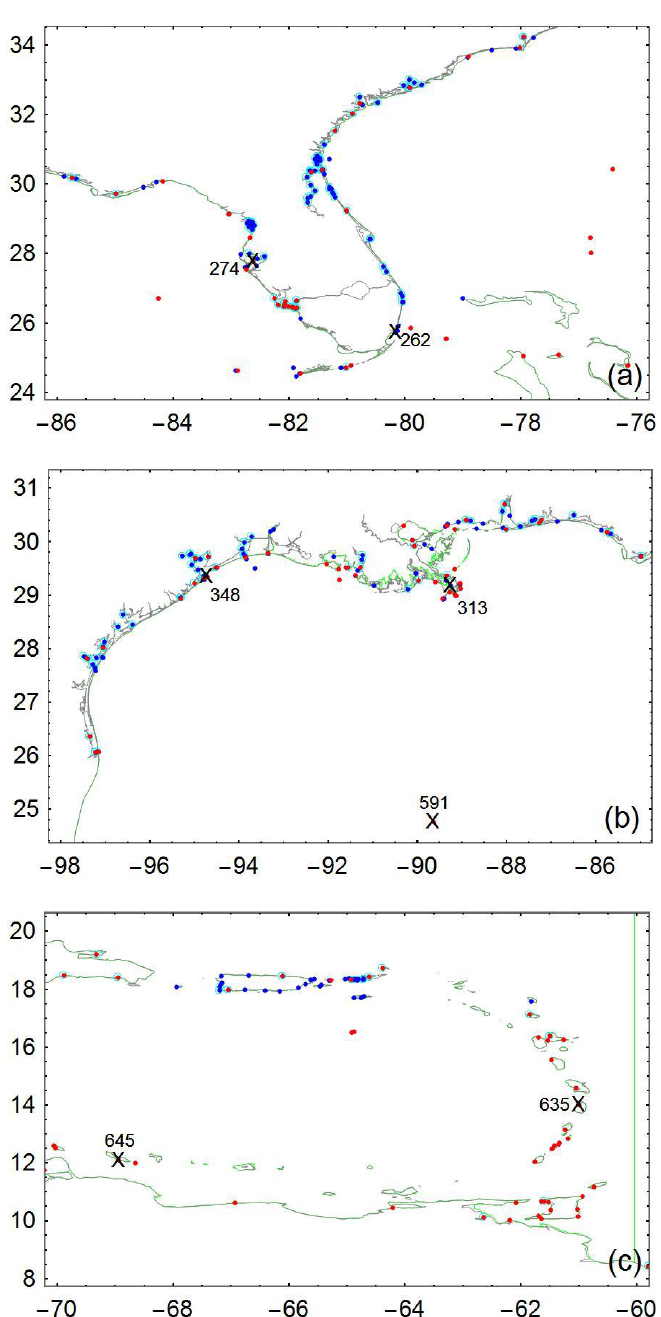
Figure 6. Locations for the stations available for validating the WNAT tidal databases: ( a ) Florida, ( b ) Gulf of Mexico and ( c ) Caribbean Sea. Blue points are from NOAA, red points are from IHO, cyan circles indicate stations that are in EC2015 (gray boundaries) but are not wet in EC2001 (green boundaries). Scatterplots are shown in Appendix B for points shown by an X.